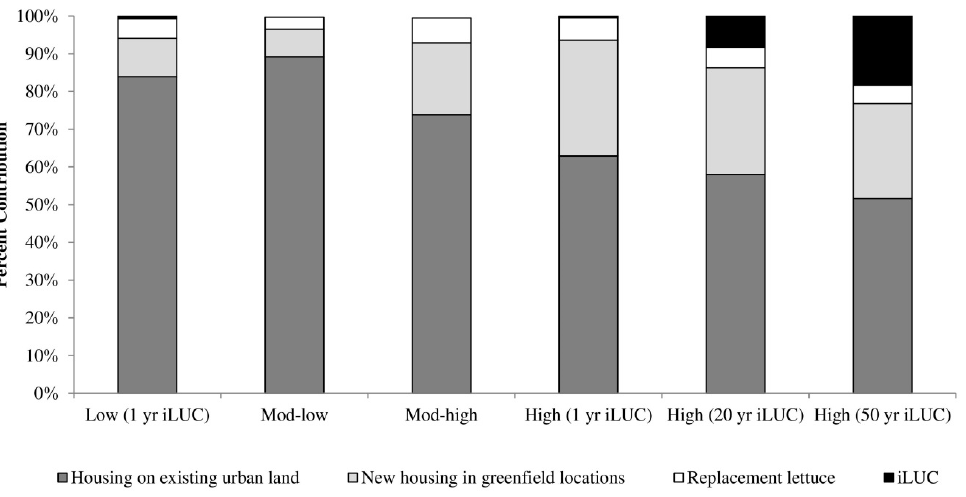
Figure 6. Percent contribution of infill housing on existing urban land; new housing in greenfield locations; replacement of PU lettuce; and indirect land use change to GHG emissions per area of PU land transformed for the four future scenarios at time horizon 2100.